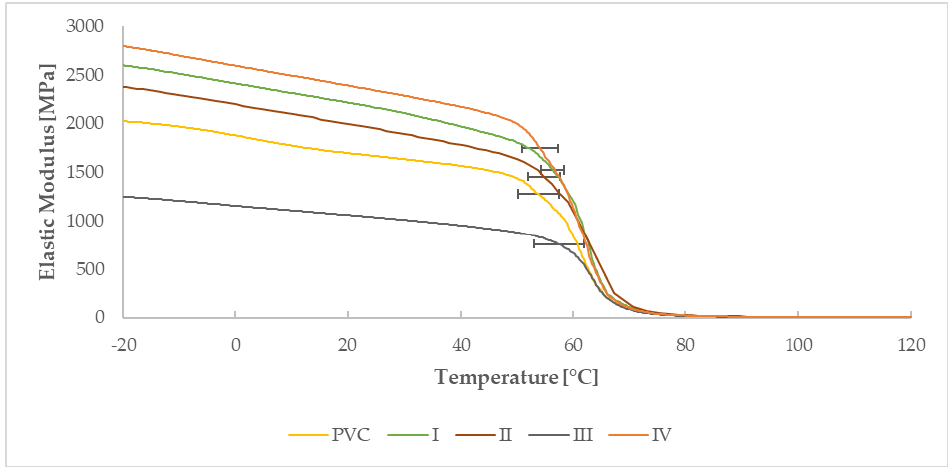
Figure 16. Determined curves of the elastic modulus of the PVC, I, II, III, IV sample.